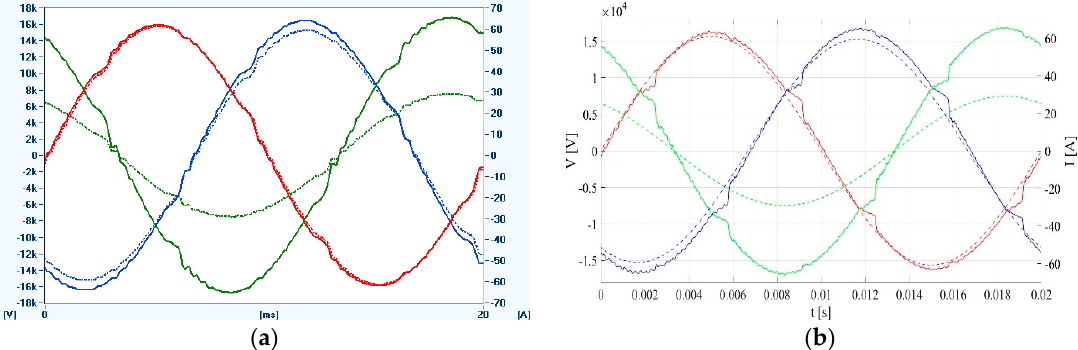
Figure 29. The voltages (full line) and the currents (chain line): ( a ) the measurement; ( b ) the simulation. The second load was represented by an engine with the PF value of 0.77 with inductive character. The graphic dependencies are shown in Figure 30.